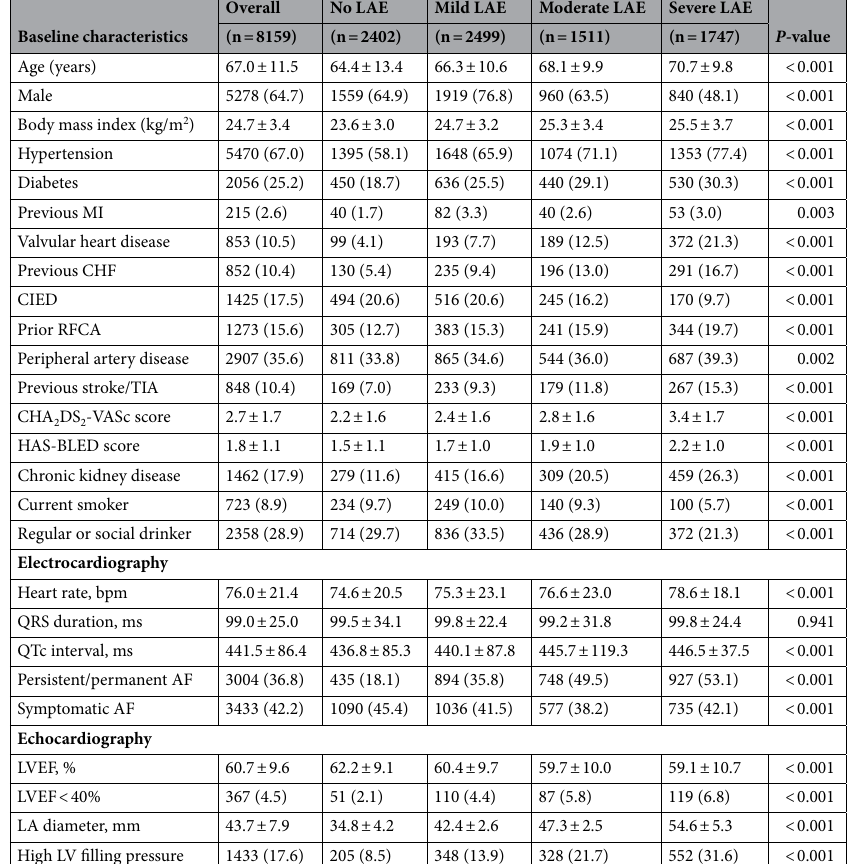
Table 1. Baseline demographics of the study patients according to the degree of left atrial enlargement based on the left atrial anterior–posterior dimension. AF atrial fibrillation, CHF congestive heart failure, CIED cardiac implantable electrical device, LA left atrial, LV left ventricle, LVEF left ventricular ejection fraction, MI myocardial infarction, QTc corrected QT interval, RFCA radiofrequency catheter ablation, TIA transient ischemic attack. Data are presented as mean ± standard deviation or number (%).